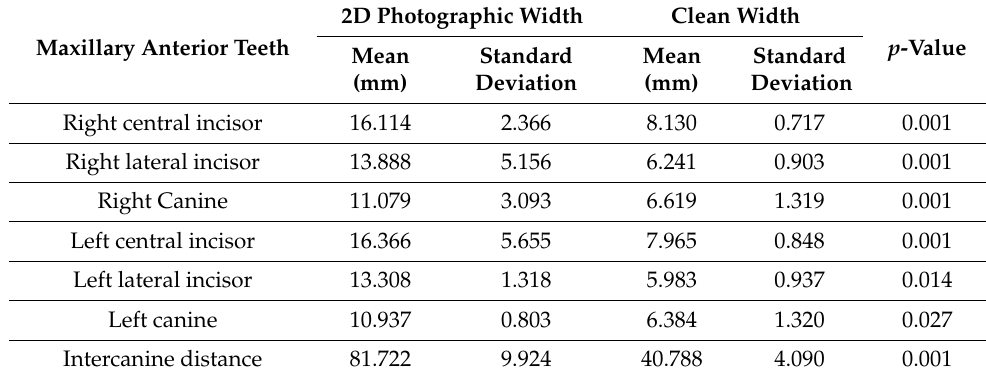
Table 3. The comparison of mean maxillary anterior teeth widths obtained from 2D photographs and clean width obtained after photographic error assessment ( n =